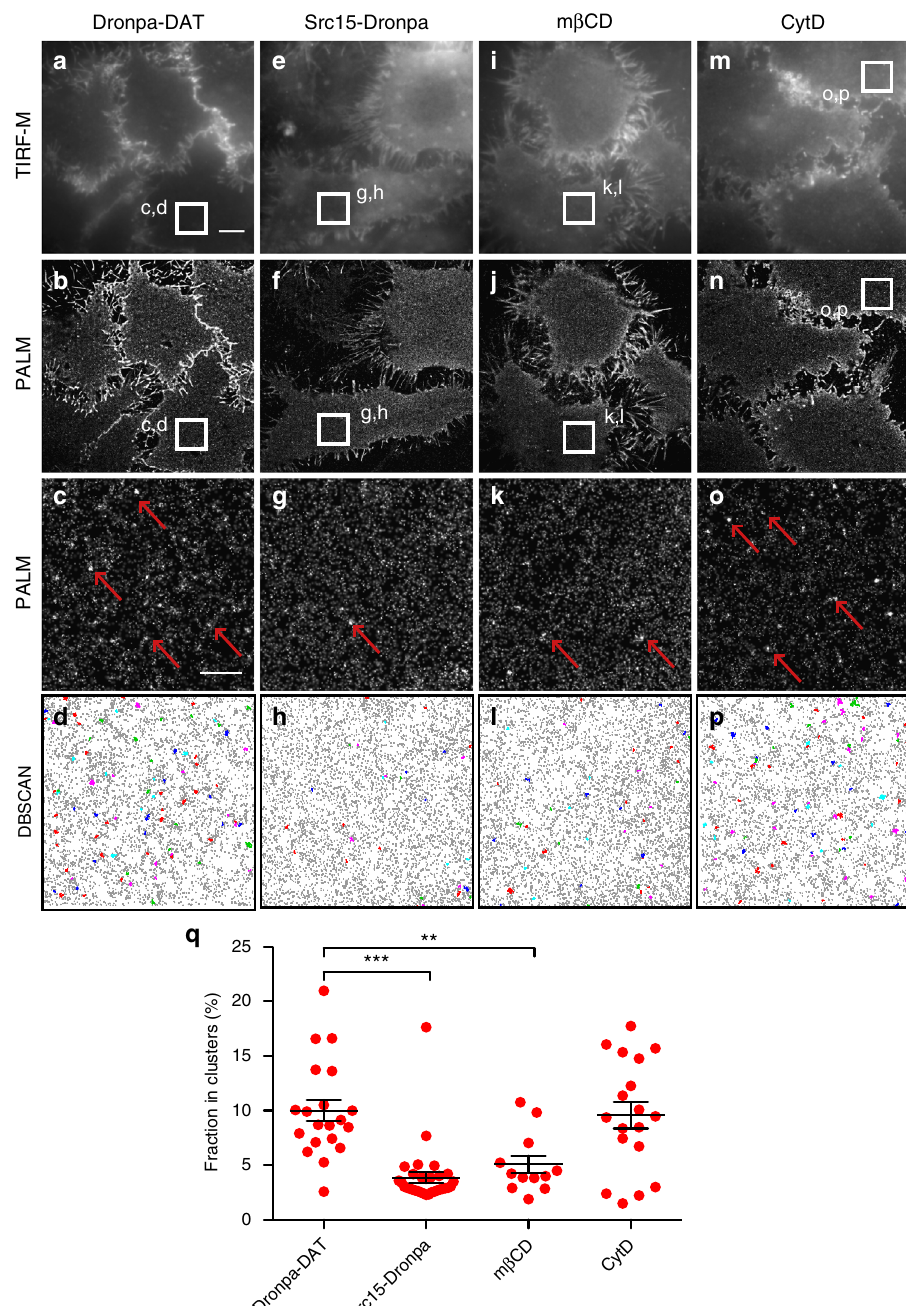
Fig. 1 Dronpa-DAT distributes to cholesterol-dependent nanodomains in the plasma membrane of living CAD cells. a – d Images of untreated live CAD cells transiently expressing Dronpa-DAT. a TIRF-M image. b Reconstructed PALM image. c Enlarged PALM image corresponding to the boxed region in a , b . d DBSCAN-based cluster map of Dronpa-DAT distribution. Clustered localizations are shown by color-coding with non-clustered localizations in gray . e – h Images of live CAD cells expressing the myristoylated N-terminus of p60 SRC fused to Dronpa (Src15-Dronpa). e TIRF-M image, f reconstructed PALM image. g Enlarged PALM image corresponding to the boxed region in e , f . h DBSCAN-based cluster map of Src15-Dronpa distribution. Clustered localizations are shown by color-coding with non-clustered localizations in gray . i – l Images of Dronpa-DAT expressing CAD cells treated with 5 mM methyl- β -cyclodextrin (m β CD) to remove cholesterol. i TIRF-M image, j reconstructed PALM image. k Enlarged PALM image corresponding to the boxed region in i , j . i DBSCAN-based cluster map of Dronpa-DAT distribution. m – p Images of Dronpa-DAT expressing CAD cells treated with 5 μ g ml − 1 cytochalasin D (CytD) to disrupt the actin skeleton. m TIRF-M image, n reconstructed PALM image. o Enlarged PALM image corresponding to the boxed region in m , n . p DBSCAN-based cluster map of Dronpa-DAT distribution. q Clustering of Dronpa-DAT measured as the fraction in % of total localizations (means ± s.e.m., * p < 0.05, one-way ANOVA with a Bonferroni ’ s post-test). Data are based on 12 – 20 cells from three independent experiments. Red arrows mark examples of DAT clustered in nanodomains. Scale bars a , b , e , f , i , j , m , n 5 μ m, c , d , g , h , k , l , o , p 1 μ m